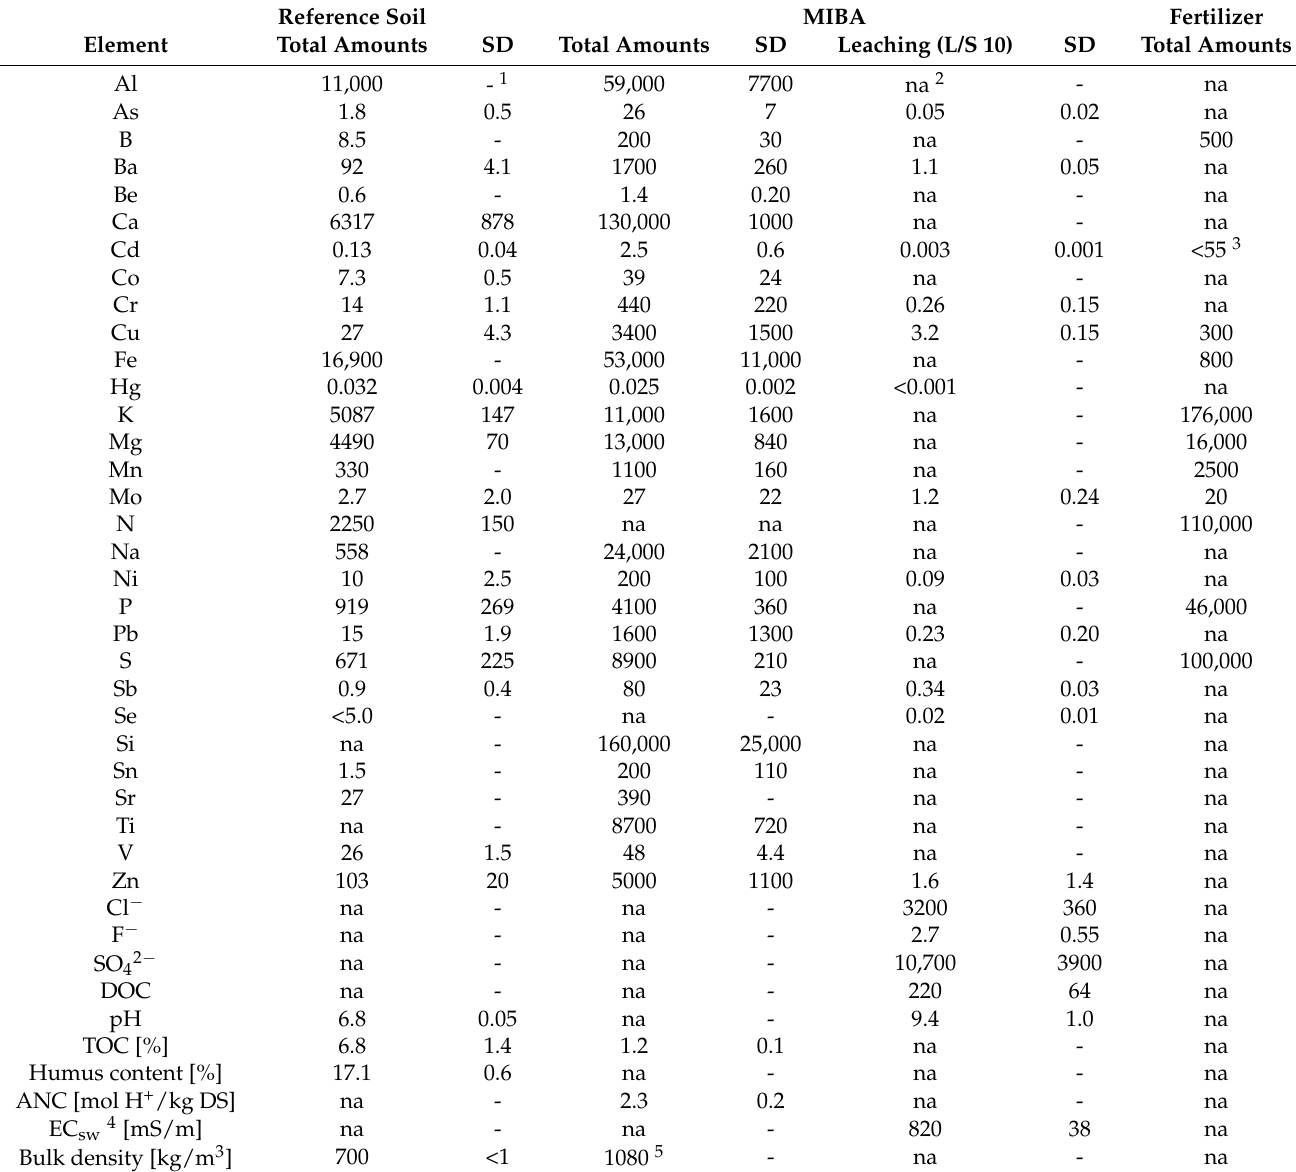
Table 1. Contents in original reference soil, MIBA and the fertilizer used. Additionally, leaching (L/S 10) from MIBA according to SS-EN-12357-3 is shown. All amounts are provided in mg/kg DS except pH, TOC, ANC, EC, and bulk density. Reference Soil MIBA Fertilizer